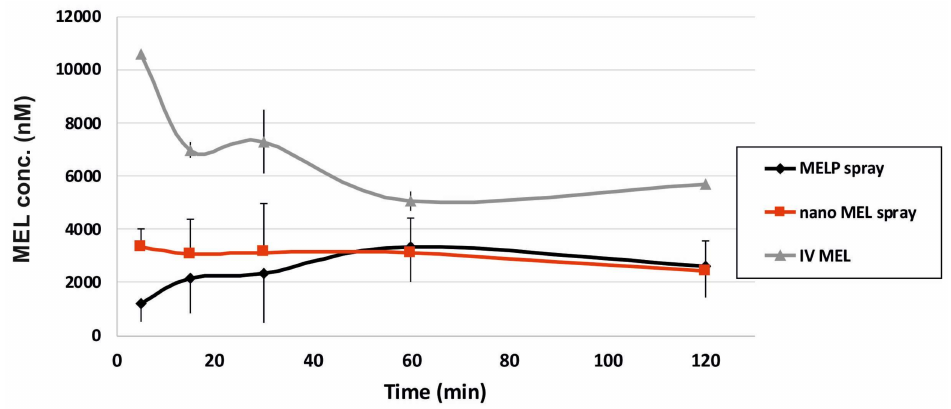
Figure 4. Plasma drug concentration vs. time profiles in rats after IV MEL and intranasal administration of nano MEL and MELP sprays.